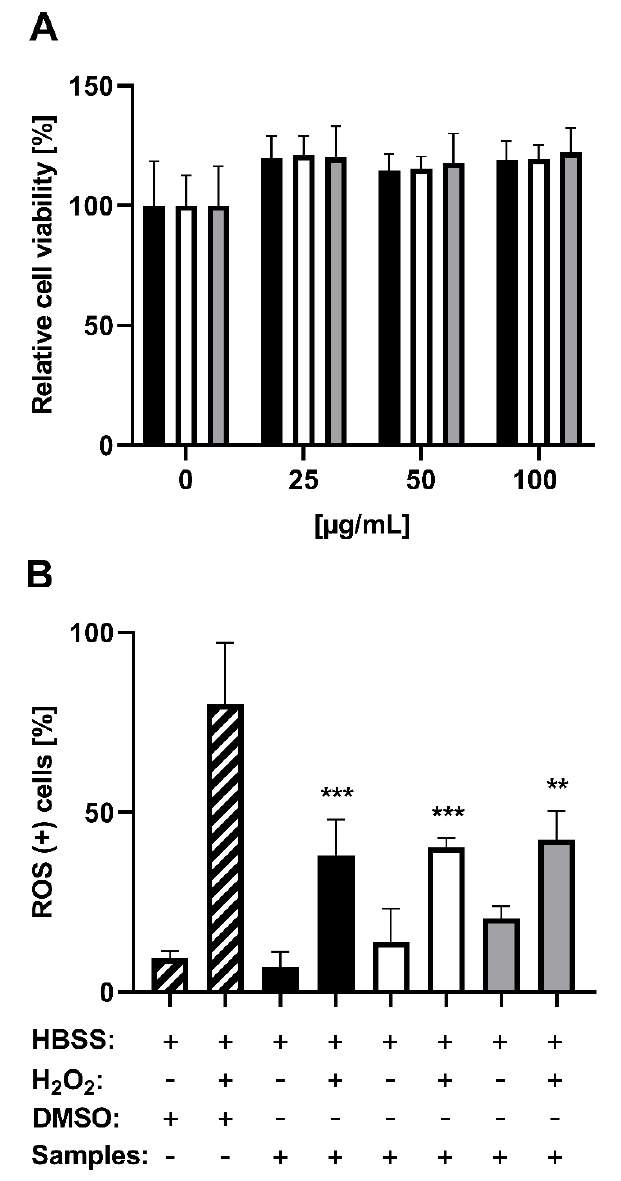
Figure 5. In vitro characterization of cytotoxic and reactive oxygen species (ROS)-reducing effects of pomegranate XAD-7 extract (black bars), the anthocyanin fraction (white bars), and the copigment fraction (grey bars) using HepG2 cells. Shown is the mean ± SD of three independent experiments. ( A ) MTT assay using 0.1% DMSO as solvent control (0 μ g/mL). Statistical analysis was performed by